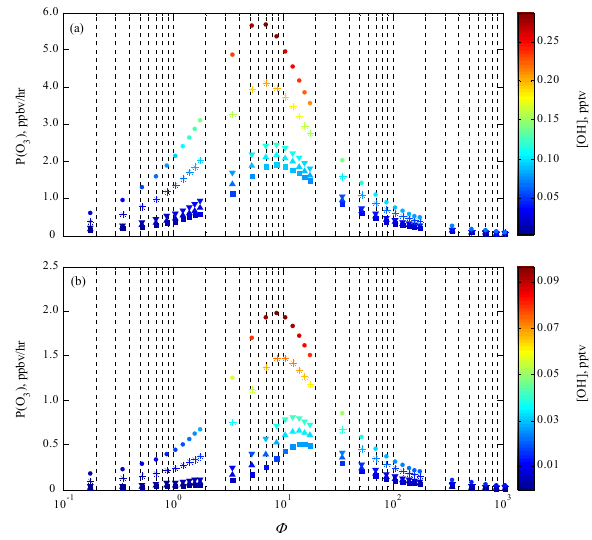
Fig. 7. Dependence of P (O 3 ) on Φ when the concentration of O 3 is constrained to 1 ppbv (shown by square), 5 ppbv (shown by upward pointing triangle), 10 ppbv (shown by downward pointing triangle), 50 ppbv (shown by asterisk) and 100 ppbv (shown by dot), respectively. The photolysis rates are constrained to those observed at (a) 1150JST and (b) 0600JST of 18 September. The NO/NO 2 ratio and other conditions are constrained to those observed at 1150JST of 18 September. The color of the dots denotes the mixing ratio of OH radical.